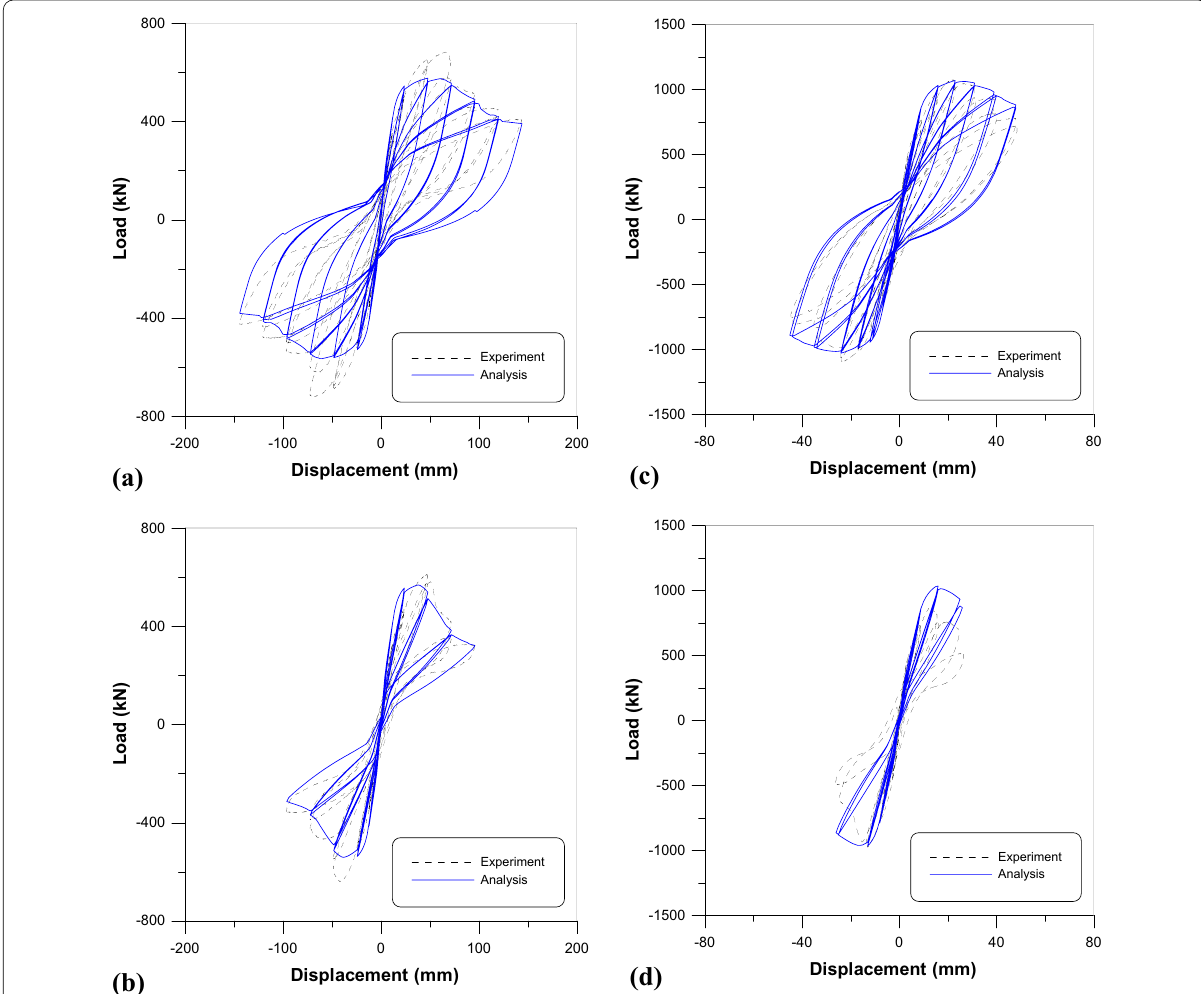
Fig. 12 Load–displacement curve for plastic hinge analysis: a Specimen NS‑HT2‑H‑L2, b Specimen NS‑HT2‑A‑L2, c Specimen FS‑H‑LS050, and d Specimen FS‑H‑LS100.